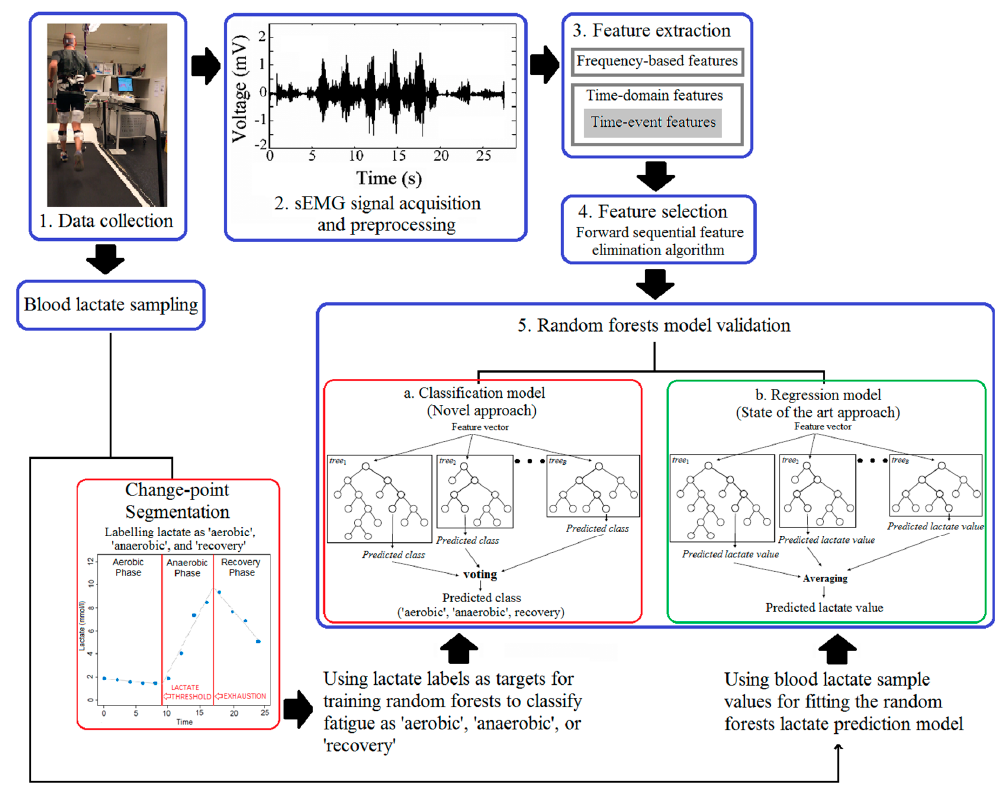
Figure 1. Schematic diagram of the study design. After data collection and data preprocessing, the study tested two ways to predict lactate levels of the athletes during the incremental running test,